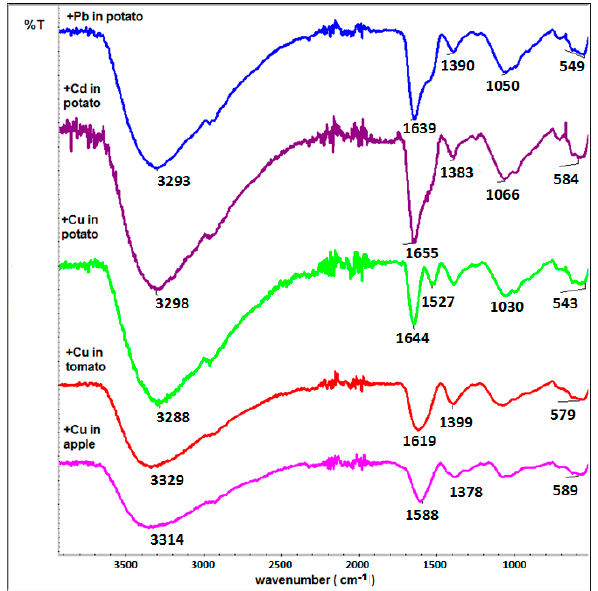
Figure 4. IR spectra of ferrite nanoparticles modified by SA after heavy metal detection from tested